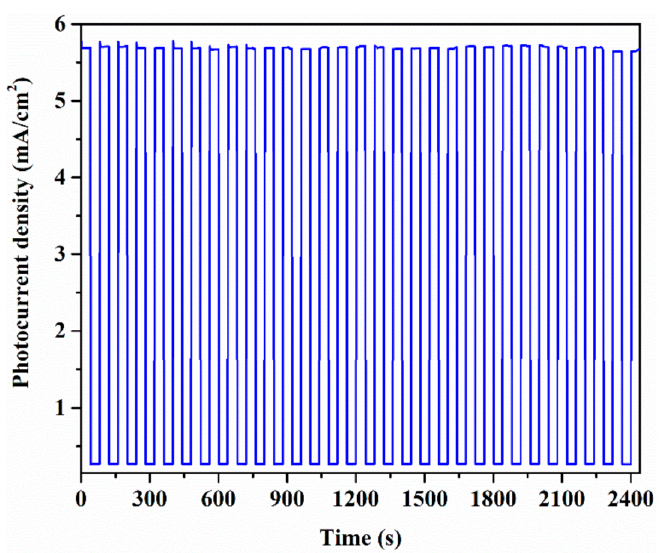
Figure 6. SnS nanosheet chronoamperometry chopped visible light at 0.04 V versus Ag/AgCl.